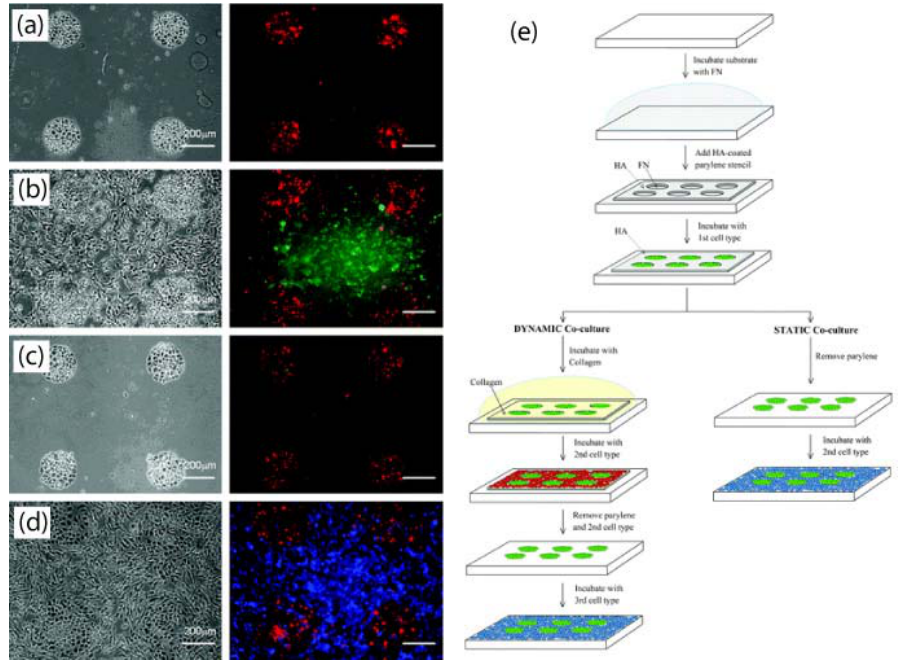
Figure 11. Light micrograph (left) and the corresponding fluorescent (right) images of the steps in the formation of dynamic co-cultures using parylene-C stencils. (a) A hyaluronic acid (HA) coated parylene-C stencil was reversibly sealed on fibronectin (FN) treated PDMS and seeded with mES cells. (b) The patterned co-cultures of mouse embryonic stem cells (mES) and AML12 hepatocytes. (c) To generate dynamic co-cultures, the stencil was gently peeled away, leaving the mES cells. (d) After depositing a layer of FN, a third cell type (NIH-3T3) was seeded on the exposed surface. (e) Schematic diagram of the process used to generate static and dynamic co-cultures. Reproduced and adapted from reference [49] (DOI: 10.1039/b706081e) by permission of The Royal Society of